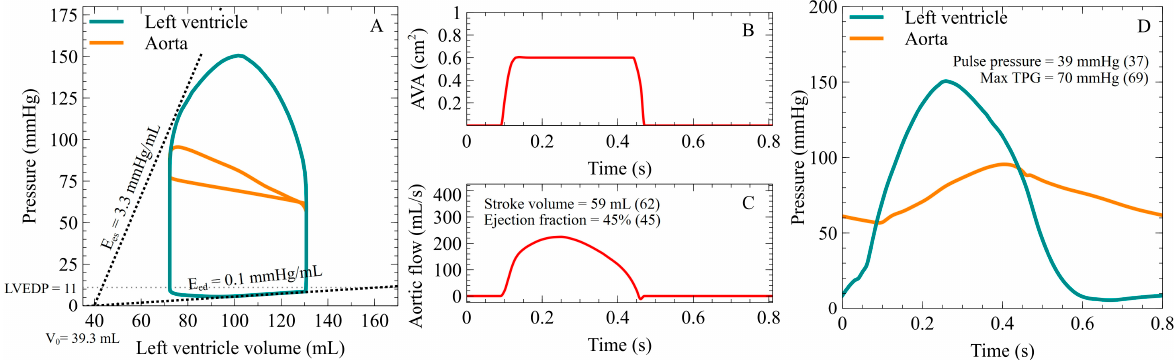
Figure 2. 1D mathematical model coupled with aortic valve stenosis model for the prediction of TPG. ( A ) Predicted left ventricular and aortic pressure–volume curve from the model (input variables E es = 3.3 mmHg/mL, E ed = 0.1 mmHg/mL, V 0 = 39.3 mL and LVEDP = 11 mmHg, and maximal AVA = 0.6 cm 2 ). ( B ) Aortic valve opening as a function of time derived by the aortic valve stenosis model. ( C ) Aortic flow, generated by the coupled 1D mathematical and the aortic valve stenosis model. ( D ) Performance of the model in predicting TPG as compared to the actual measured values from the literature